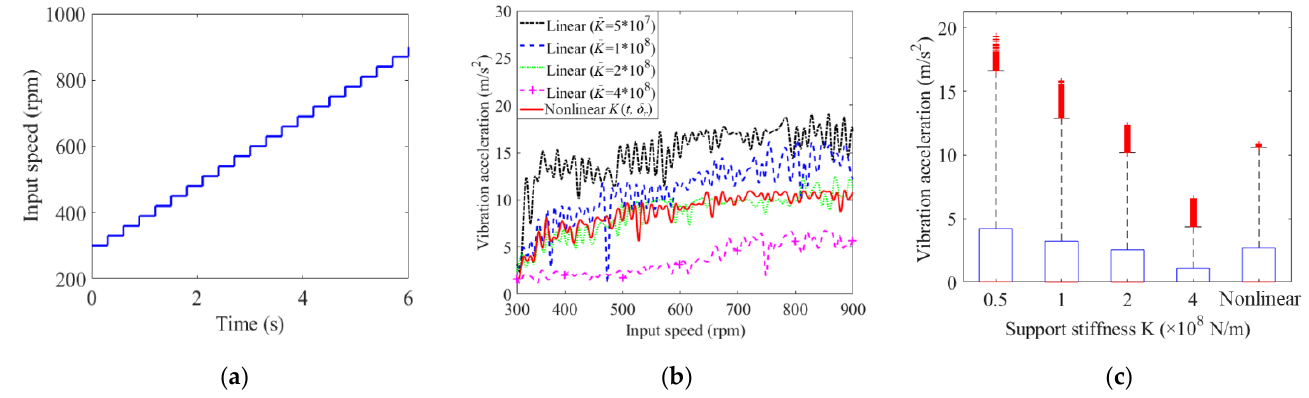
Figure 14. Acceleration under different bearing support stiffness cases and rotating speeds: ( a ) time- history input speed, ( b ) time-history vibration response, and ( c ) boxplot.